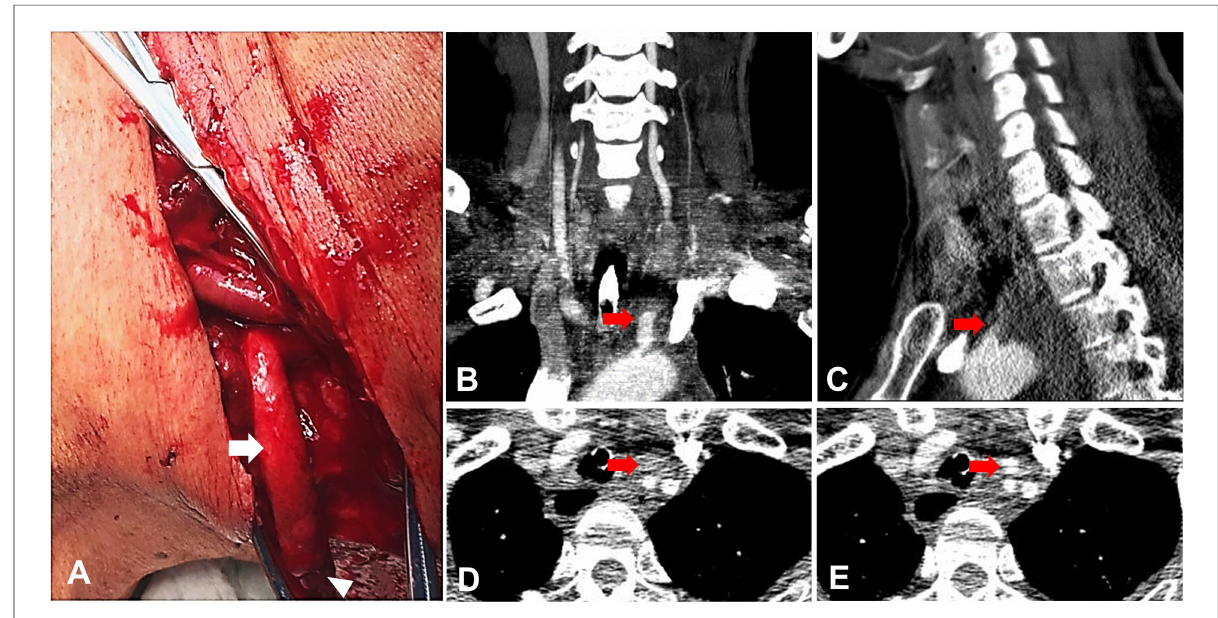
FIGURE 2 Case 2: ( A ) the left common carotid artery that was severed from the proximal end of the heart and prolapsed at the time of treatment. Note: the arrow points to the left common carotid artery. The triangle points to the distal end of the left common carotid artery. The cervical CT coronal ( B ) and sagittal ( C ) images showed that the origin of the left common carotid artery was not shown, the contrast fi lling was not seen in the distance, and the structure was not clearly displayed. Note: the arrow refers to the beginning of the left common carotid artery. ( D ) The left common carotid artery was not seen at the CT level of the neck. Note: the arrow refers to the location of the left common carotid artery. ( E ) Normal development of the left common carotid artery at the level of the CT in the neck. Note: the arrow refers to the left common carotid